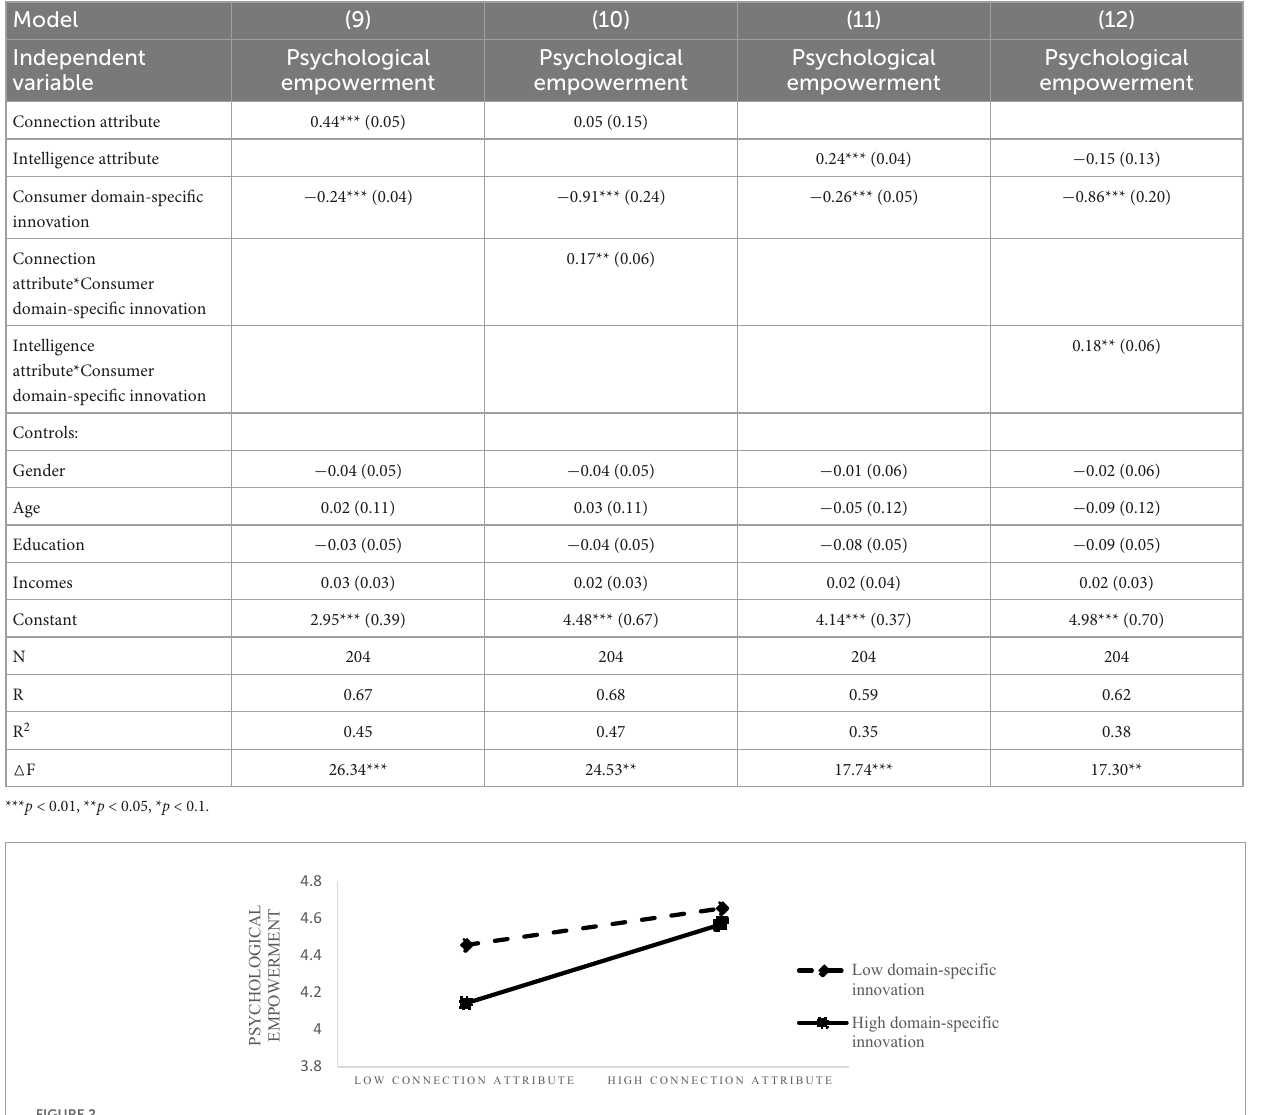
TABLE 5 Moderating effect regression results.